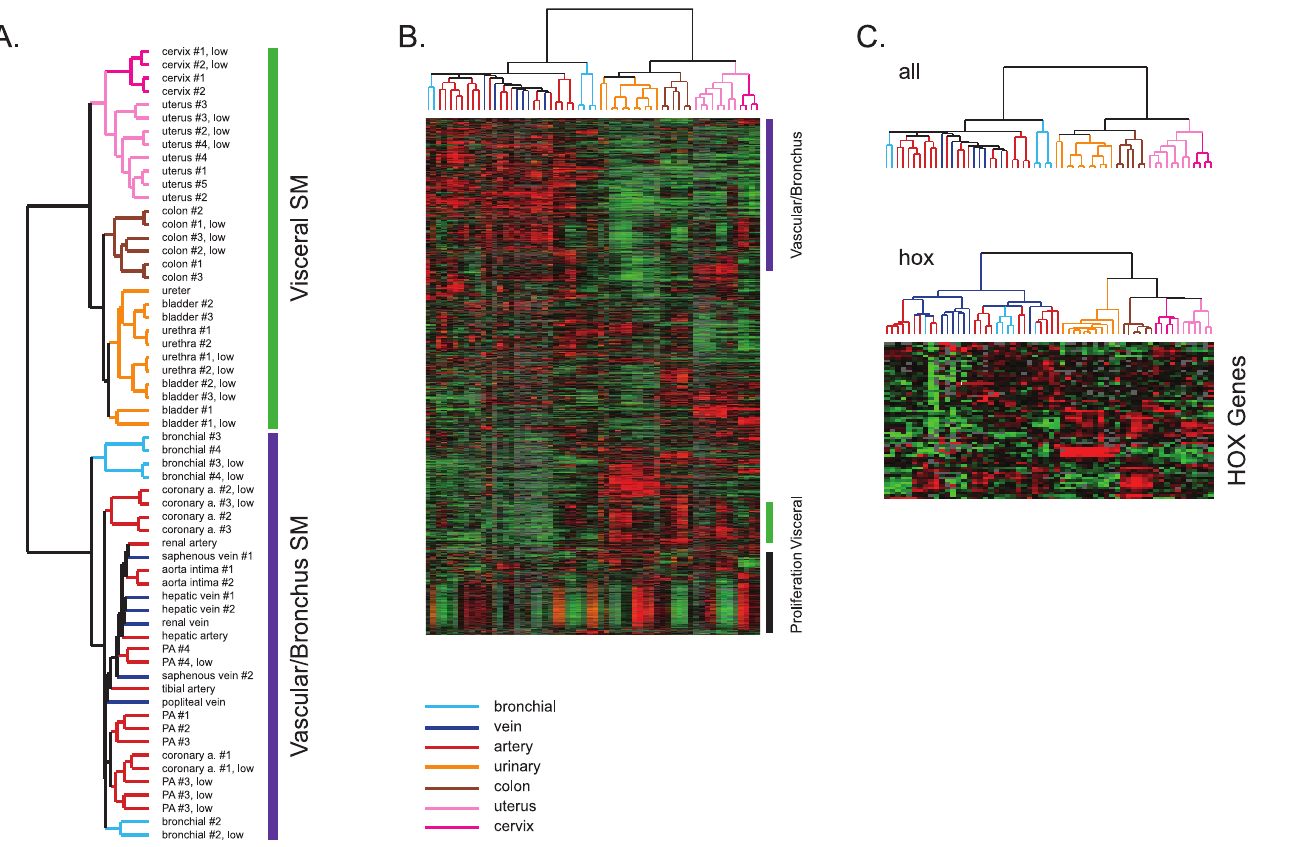
Figure 1. Diversity of SMC Gene Expression Patterns (A) Gene expression patterns of cultured SMCs organized by unsupervised hierarchical clustering. The global gene expression patterns of 60 cultured SMCs were sorted based on similarity by hierarchical clustering. Approximately 6,166 gene elements (representing 5,236 distinct genes) were selected from the total dataset, based on variations in expression relative to the mean expression level across all samples greater than 3-fold in at least two cell samples. The anatomic origins of each SMC culture are indicated and color coded. The apparent order in the grouping of SMC gene expression patterns is indicated in this dendrogram. (B) Overview of gene expression patterns of all SMC samples. The variations in gene expression described in Figure1A are shown in matrix format. The scale extends from 0.25- to 4-fold variation from the mean across all samples ( (cid:2) 2 to þ 2 in log2 scale). Gray represents missing data. The gene clusters characteristic of vascular/bronchial, visceral SMCs, and proliferation are indicated on the right. Complete data can be found on the supplementary Web site and SMD. (C) Gene expression patterns of cultured SMCs organized by unsupervised hierarchical clustering based on expression of 63 homeodomain genes. The dendrogram generated by 63 hox genes (labeled as ‘‘ hox ’’ ) is compared with the dendrogram generated by all genes (labeled as ‘‘ all ’’ ).